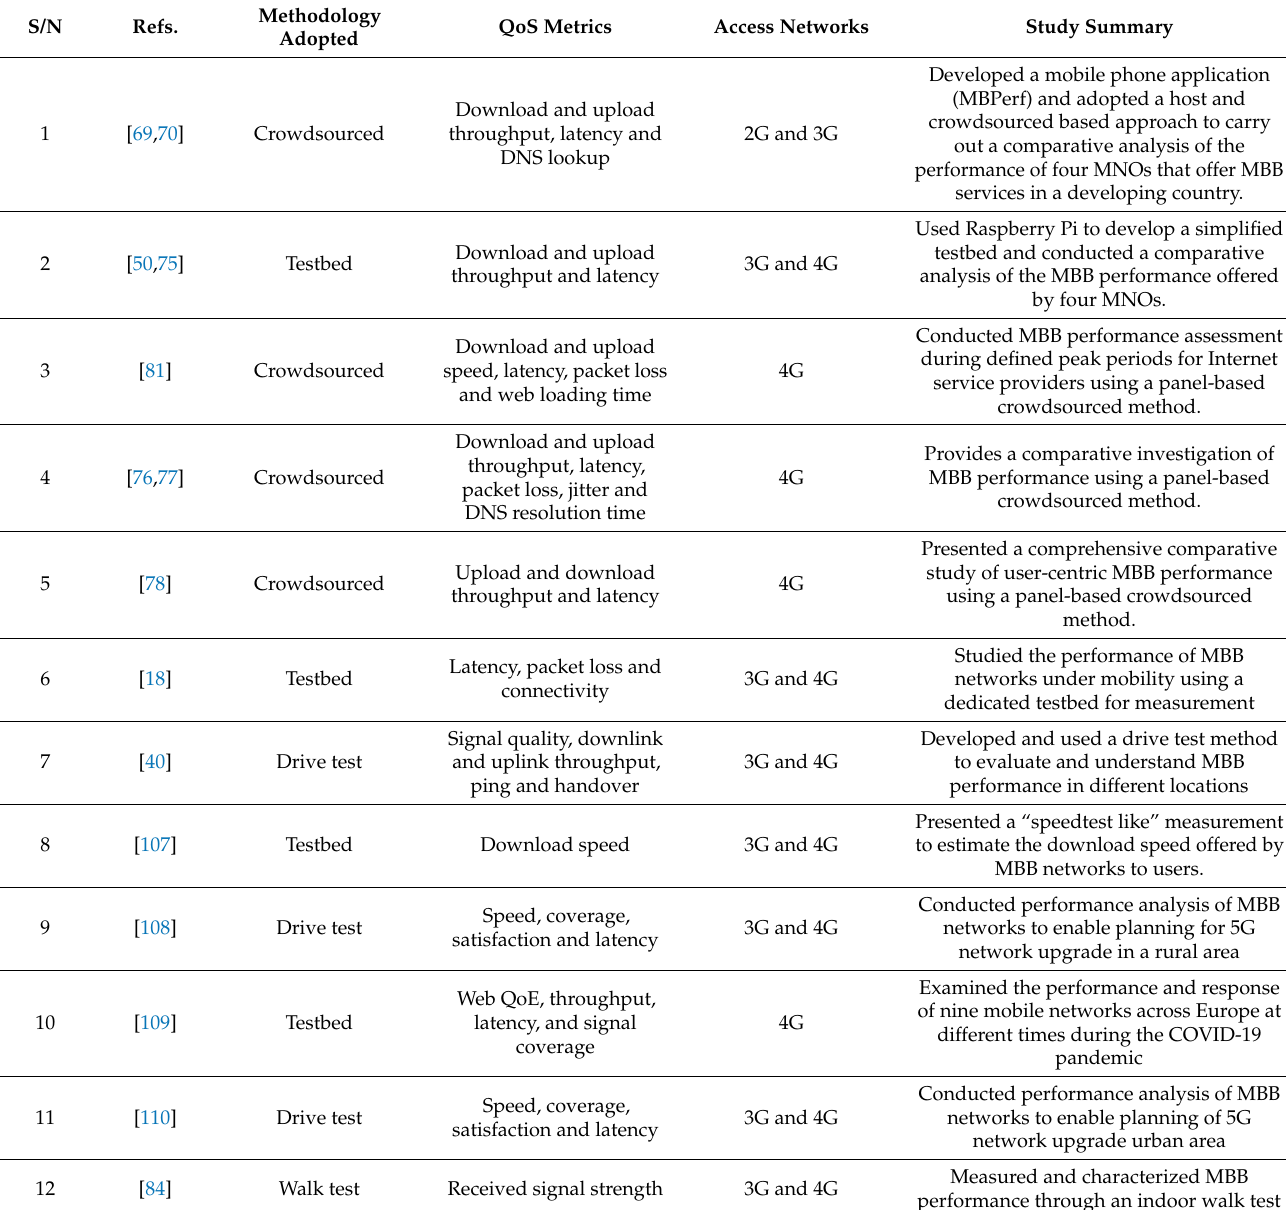
Table 8. Summary of existing mobile broadband performance evaluation